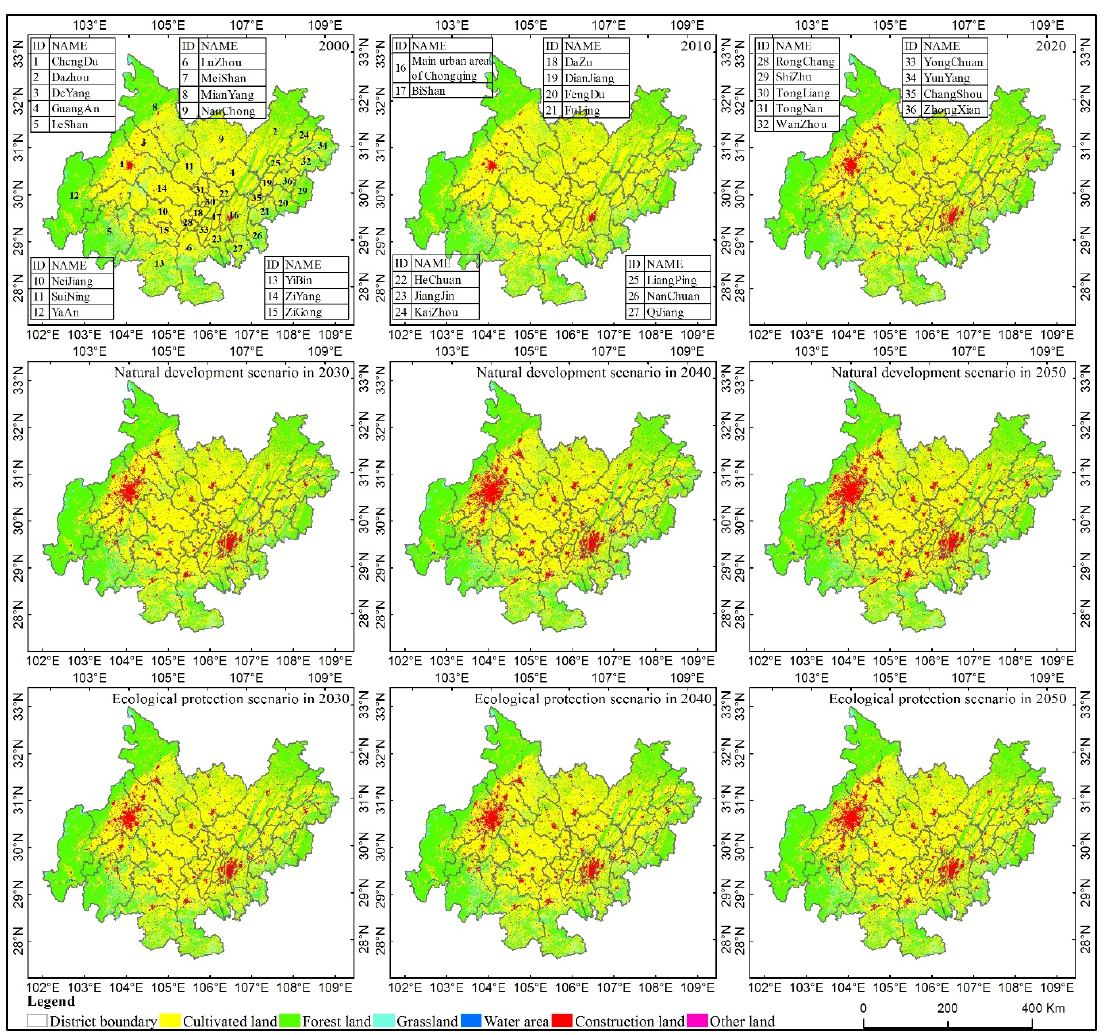
Figure 2. Distribution of the simulation results of land use data in the C-C E Zone from 2030 to 2050.